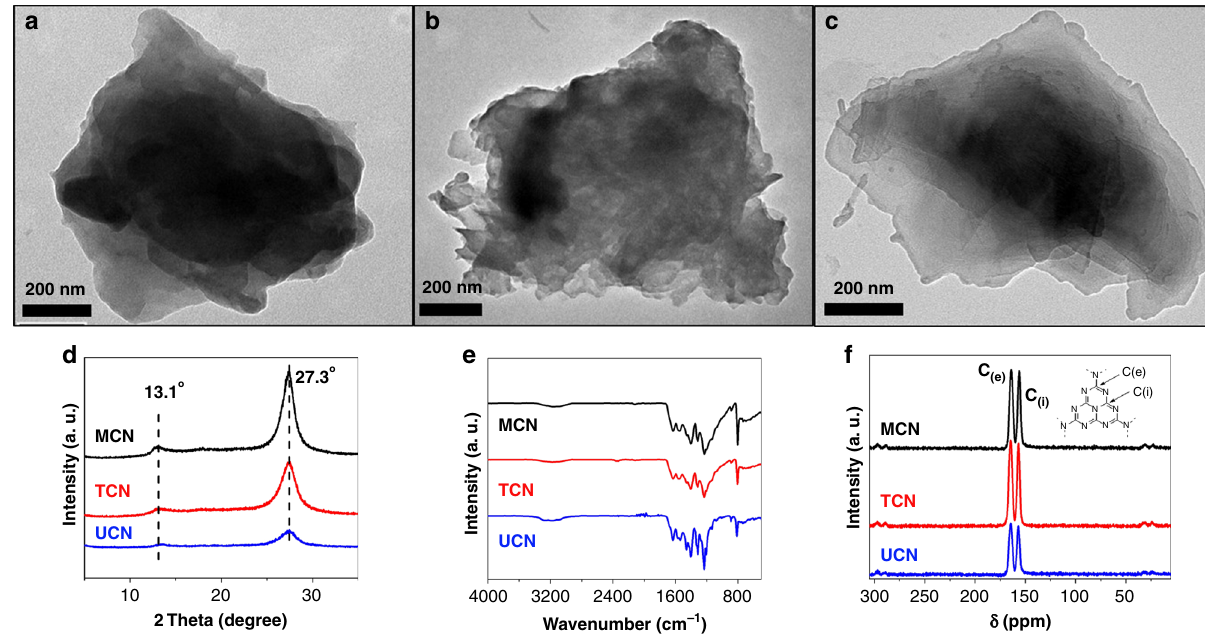
Fig. 1 The morphological and structural characterization of PCNs. a – c TEM images of MCN, TCN, and UCN, respectively. d XRD pattern. e FT-IR spectrum. f Solid-state 13 C MS-MAS NMR. Table 1 The physical and optical properties of three CNs.